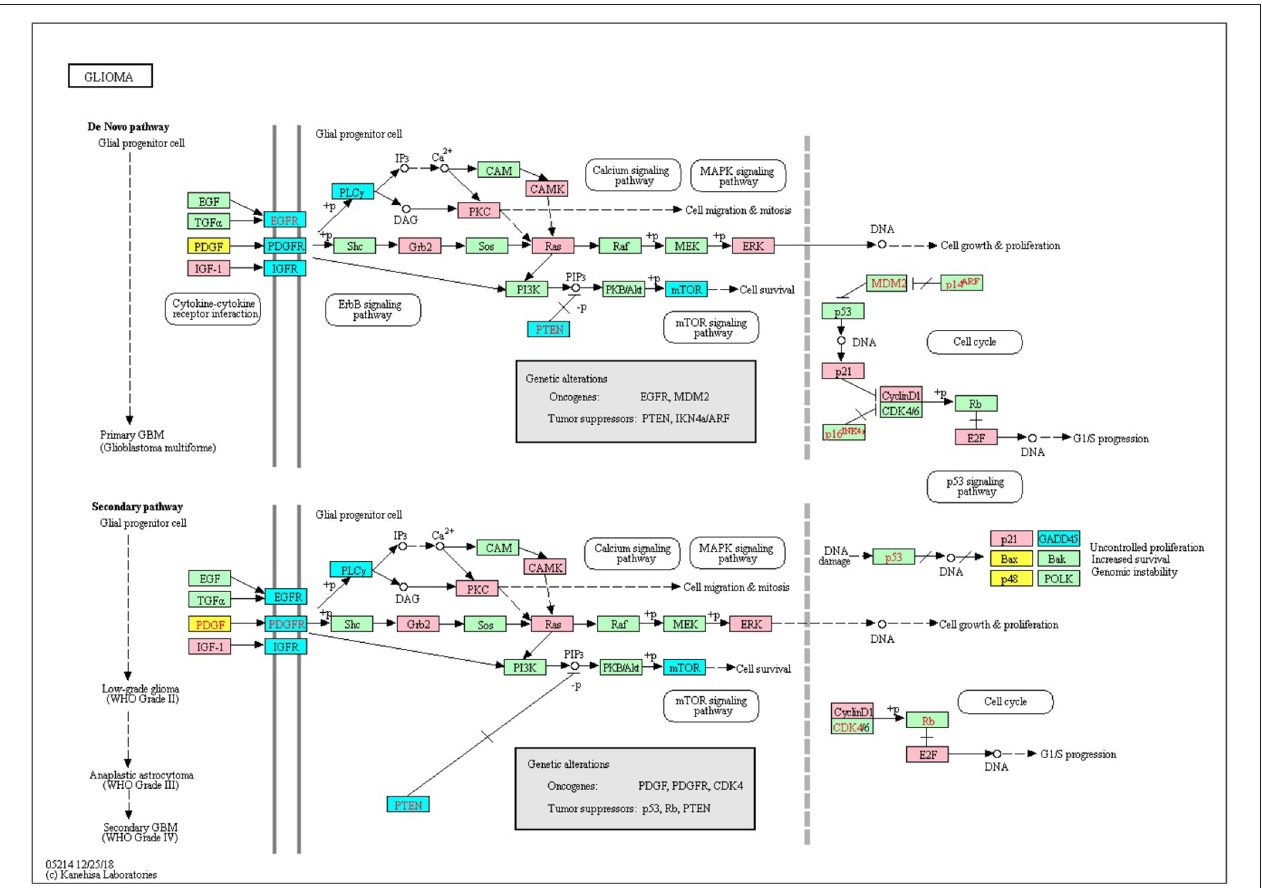
FIGURE 5 | The top 25% genes from the IRENE and promoter rank list are highlighted on the KEGG glioma signaling pathway. Pink, genes from the IRENE list; yellow, genes from the promoter list; cyan, genes from both